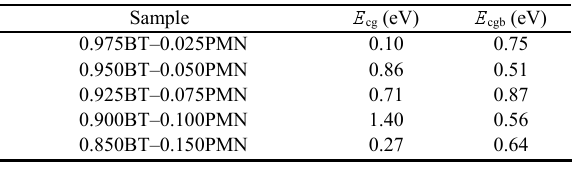
Table 2 Activation energy of grains ( E cg ) and grain